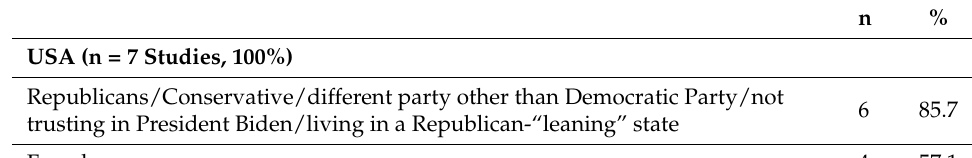
Table 6. The most frequent predictors of vaccine hesitancy per country or